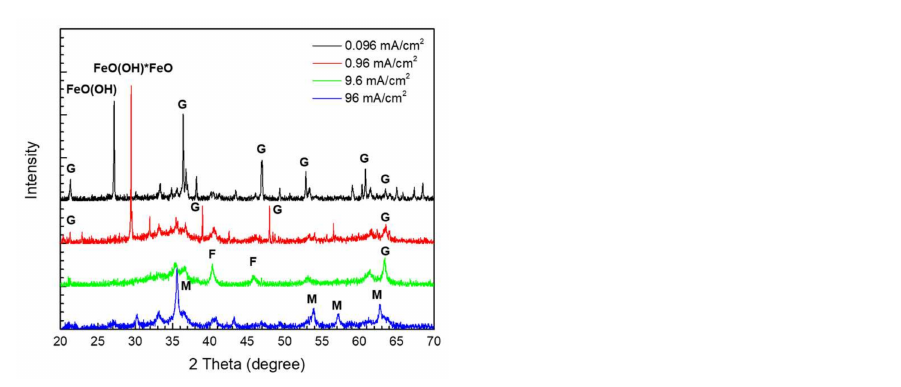
Figure 5. The XRD results following the galvanostatic tests based on current density: G: goethite ( α -FeO[OH]); F: ferrihydrite (Fe 2 O 3 · 0.5H 2 O); M: magnetite (Fe 3 O 4